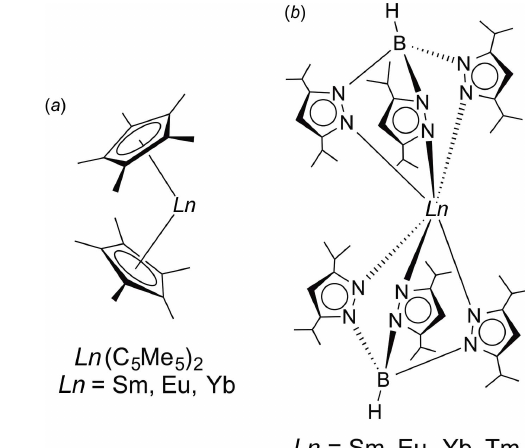
Figure 1 Comparison of the molecular structures of ‘bent sandwich’-like lanthanide(II) cyclopentadienides ( a ) and tris(3,5-diisopropylpyrazolyl)- borates ( b